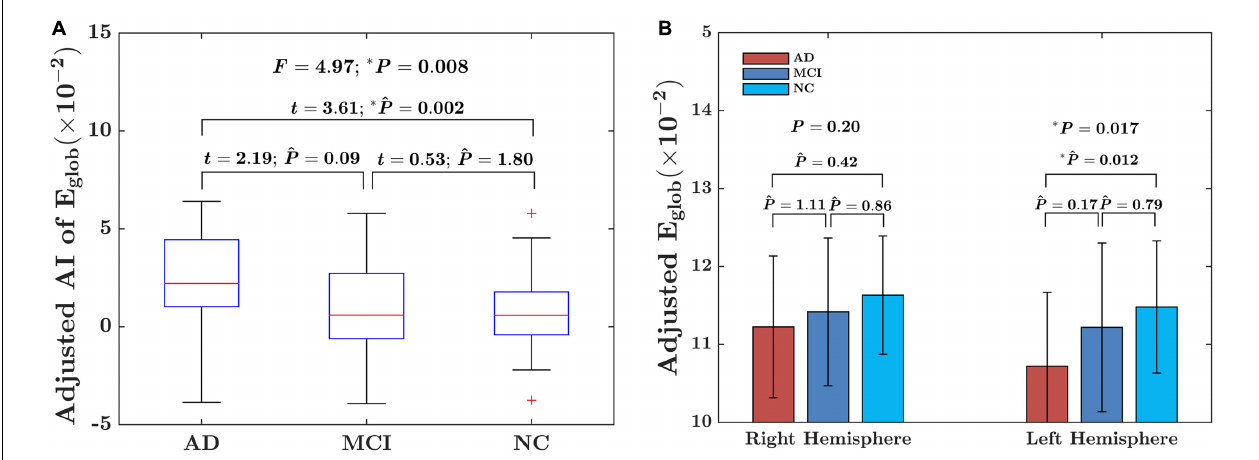
FIGURE 3 | Between-group differences in the AI of the global network efficiency of the hemispheric networks and the absolute network efficiency in the two hemispheres. (A) The box plots of the group differences in the AI of global network efficiency. Before conducting the group comparisons, the data were adjusted for whole-brain ICV, hemispheric ICV difference, age, gender, and TR and TE from diffusion-weighted imaging. (B) Bar charts depicting group differences in the global network efficiency of each hemisphere. Before conducting the group comparisons for each hemisphere, the hemispheric ICV, age, sex, and TR and TE from diffusion-weighted imaging were adjusted. ˆP represents the Bonferroni-corrected P- value of post hoc analysis.